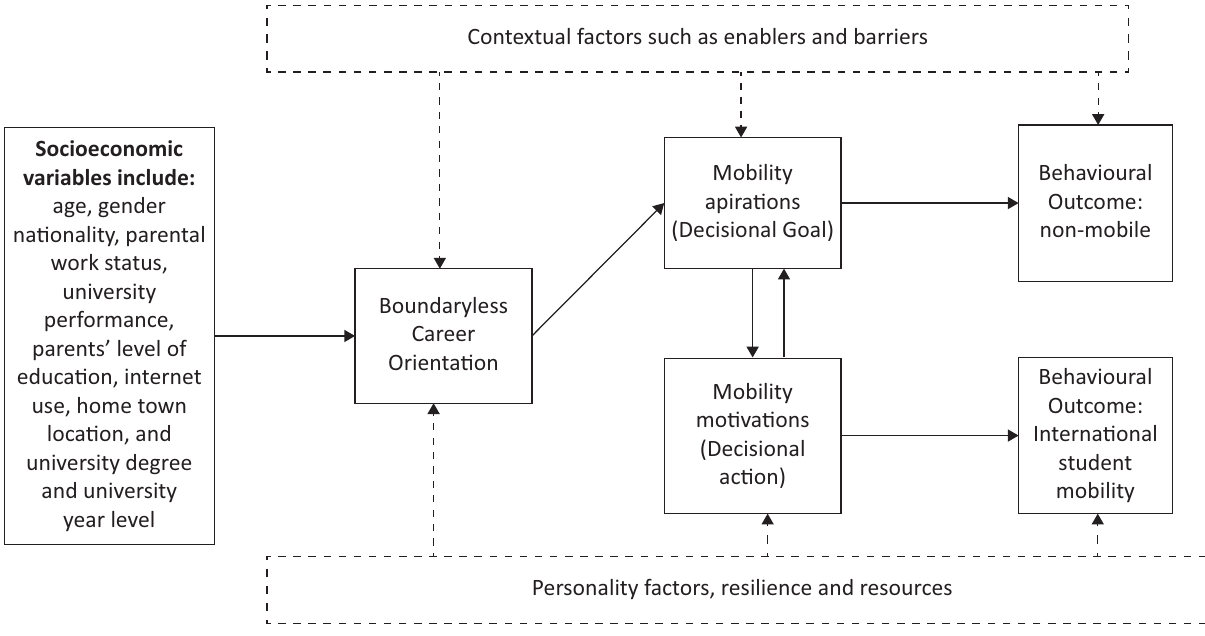
Figure 2. Boundaryless career conceptual model of international student mobility